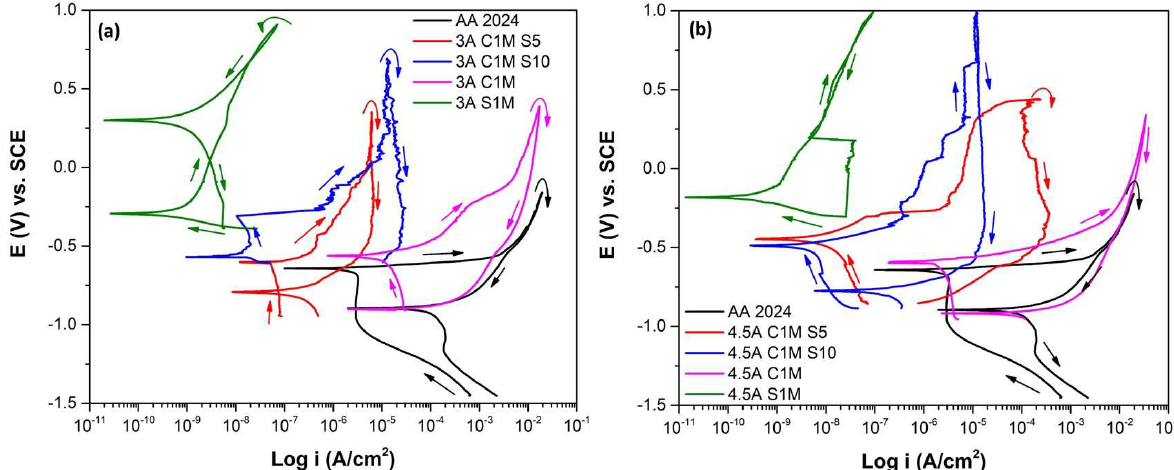
Figure 8. Cyclic potentiodynamic polarization curves of anodized samples of AA2024 immersed in NaCl solution. ( a ) i = 3 A/dm 2 and ( b ) i = 4.5 A/dm 2 .